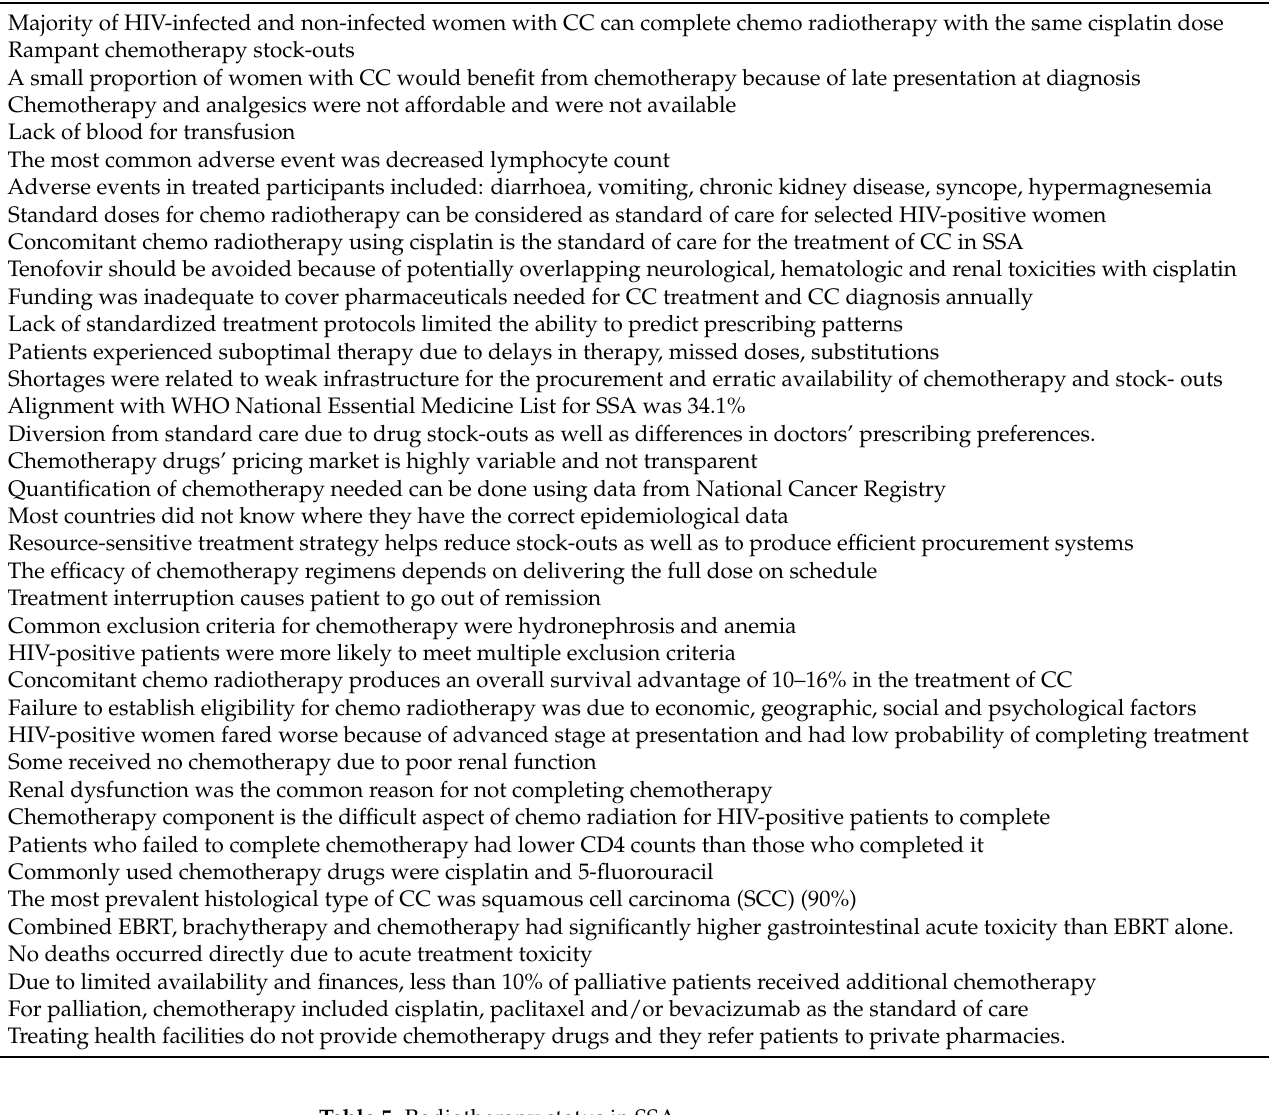
Table 4. Chemotherapy status in SSA.